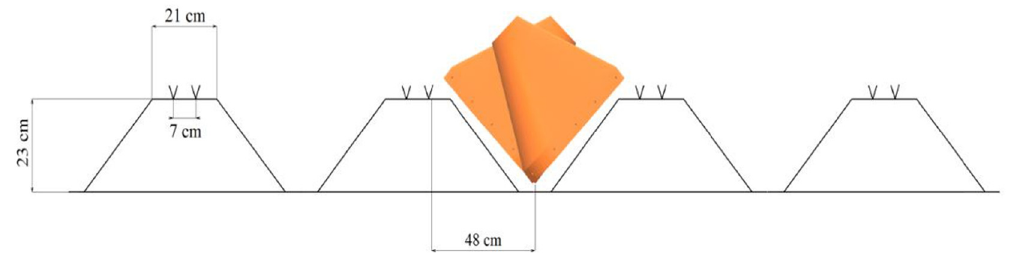
Figure 2: The width of sprayed strips and the arrangement of spraying sections in ridge carrot cultivation ( source: own work ) .